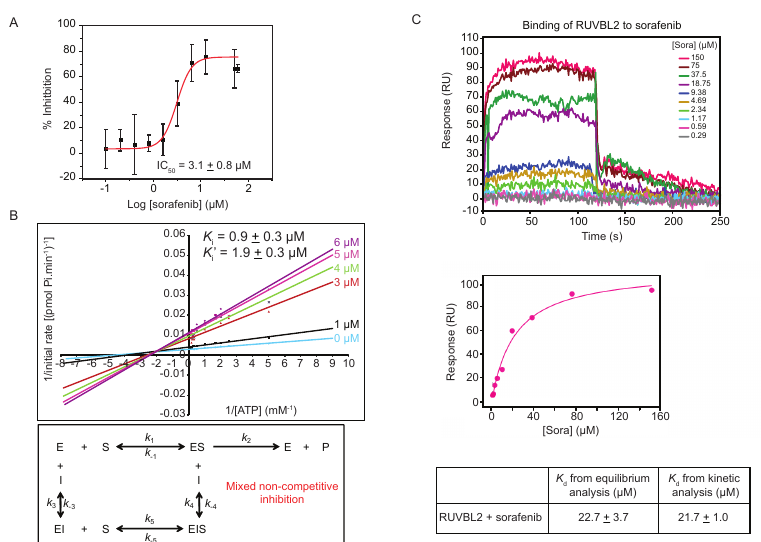
Figure 3. Mechanism of sorafenib inhibition of RUVBL2 ATPase activity. ( A ) Determination of IC 50 of sorafenib inhibitor using ATP / NADH coupled ATPase assay with 10 µ M RUVBL2, 5 mM ATP, and a range of sorafenib concentrations (0, 0.1, 0.2, 0.4, 0.8, 1.6, 3.2, 6.4, 12.8, 51.2, and 60 µ M). The IC 50 was computed using the OriginPro software. The graph shows the mean ± SD of one experiment of triplicates. ( B ) Top panel shows double reciprocal plot (Lineweaver-Burk plot) of the reaction rate with 10 µ M RUVBL2, range of ATP concentrations (0.1 to 6 mM), and increasing concentrations of sorafenib (0, 1, 3, 4, 5, and 6 µ M). Each line in the graph is the mean of one experiment done in triplicates. K i and K i (cid:48) values are reported at the top. Bottom panel shows the inhibition mechanism deduced from the pattern of Lineweaver-Burk plot. ( C ) Determination of binding constant of sorafenib to RUVBL2 using SPR. Top panel shows SPR sensorgrams of immobilized RUVBL2 WT on GLH sensor chip exposed to ten 2-fold serial dilutions of sorafenib in triplicate. SPR sensorgrams for injected sorafenib are shown as colored lines and are channel and double referenced (subtracting both interaction bu ff er signal and no ligand immobilized signal). Middle panel shows equilibrium analysis of RUVBL2-sorafenib binding. The bottom panel shows K d values calculated from equilibrium and kinetic analysis of the SPR